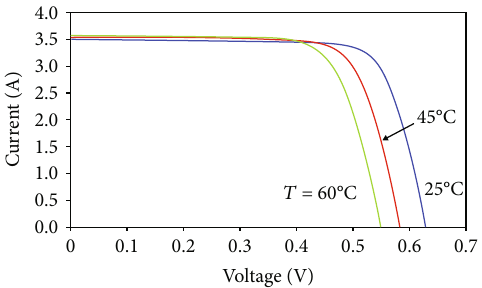
Figure 1: The impact of temperature on current and voltage of a solar cell. The reduction in voltage is higher than the increase in current; therefore, the output power of solar cell decreases with increase in